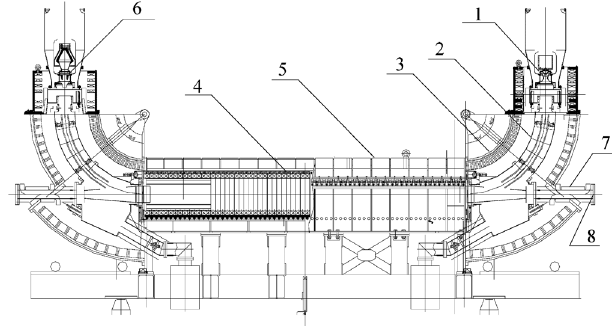
FIG. 1. General layout of the e-cooler EC35 in HIRFL- CSRm. 1-electron gun, 2-electrostatic bending plates, 3-toroid, 4-solenoid of the cooling section, 5-magnet system, 6-collector for e-beam, 7-dipole corrector, 8-flange for CSRm.